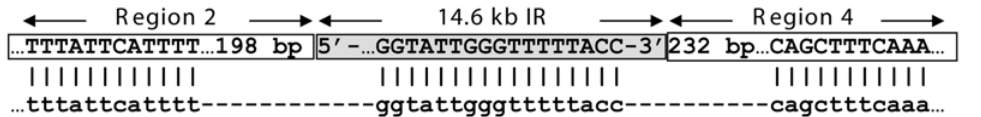
Figure 5. Structure of the LCR excision found at the proximal end of 2Rjin a subsample of the Bamako chromosomal form from Mali. Uppercase letters within boxes represent intact chromosomal regions 2 and 4, and the complete 14.6 kb LCR (shaded in gray). Shown below is the corresponding sequence after excision of the LCR. Dashes represent deleted sequence. The excision event also removed the flanking 198 bp of region 2 and 232 bp of region 4, but left 17 bp at the 3 9 end of the LCR.